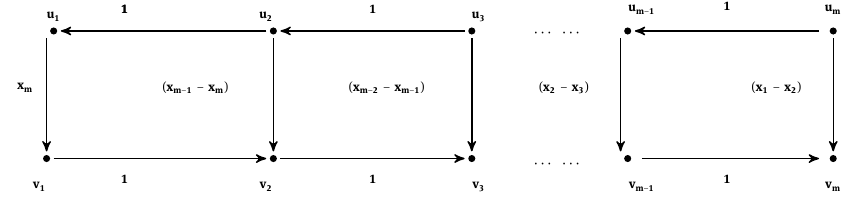
Figure 2: A weighted acyclic digraph Γ m , and the weight of each edge is described on